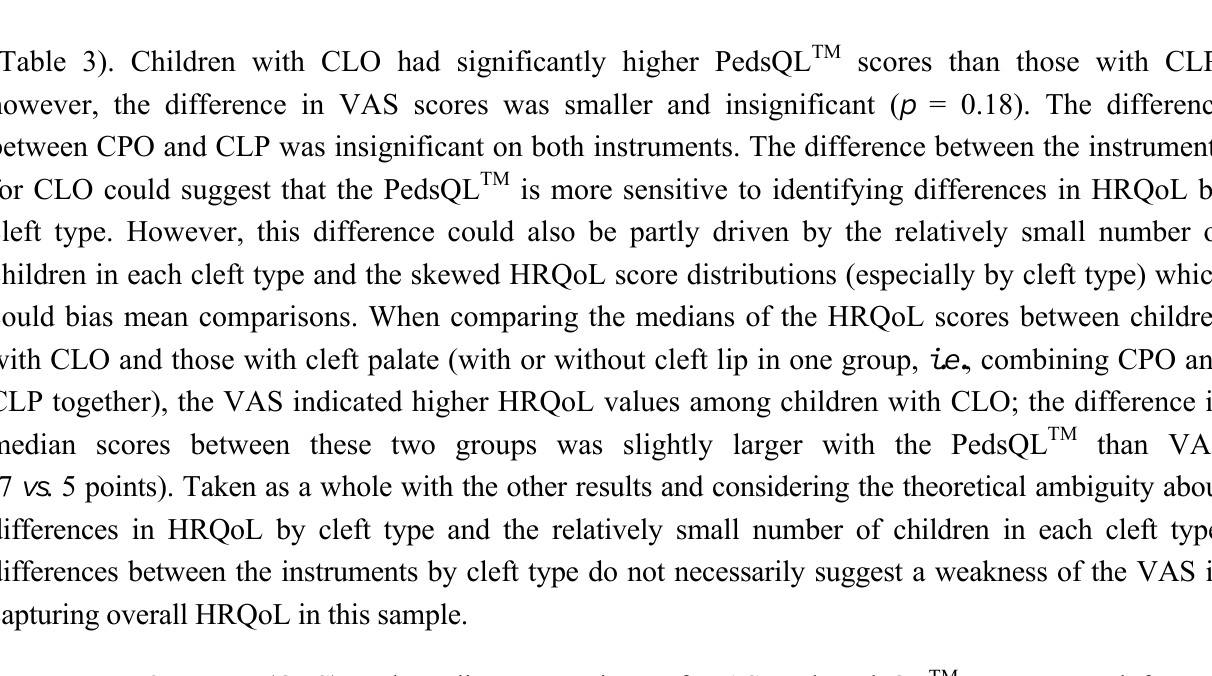
Table 3. Mean (OLS) and median regressions of VAS and PedsQL TM scores on cleft type